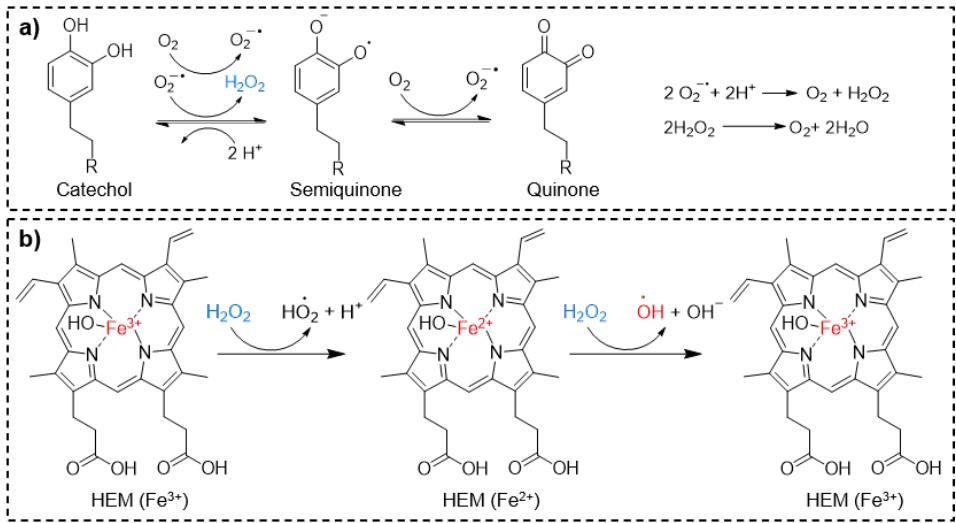
Figure 6. Schematics showing the mechanism of catechol oxidation and H 2 O 2 generation ( a ) and H 2 O 2 decomposition to generate •OH in the presence hematin (HEM) ( b ). Reproduced with permission from reference [90] copyright 2020 American Chemical Society.